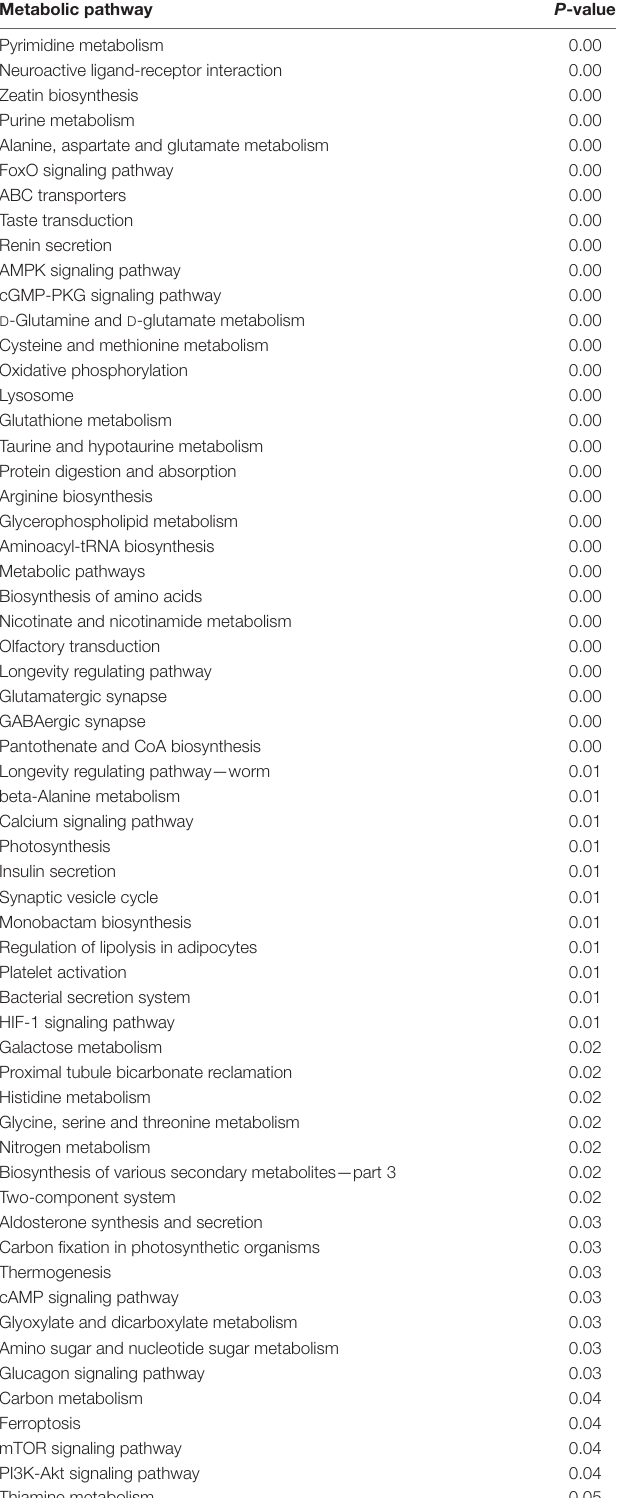
TABLE 3 | Differential metabolites in FAdV-4-infected LMH cells compared to controls in negative ion